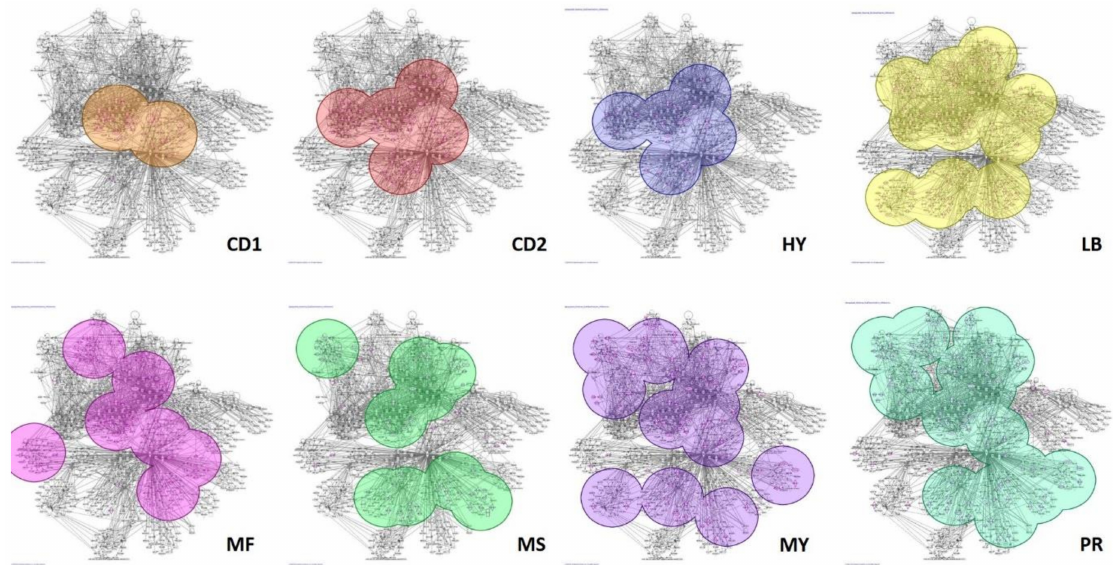
Figure 4. Myeloma Subgroups Exhibit Unique Network Characteristics. Ingenuity pathway analysis was performed on genes identified in GEP and CNV analysis from the 8 myeloma subgroups to identify common and unique protein interaction networks between the subgroups. Results from the analysis identified a common central protein network belonging to all subgroups as well as peripheral networks belonging to only one or a few of the myeloma subgroups. Each network represents the contributions of a single subgroup, highlighted in color, to the overall myeloma